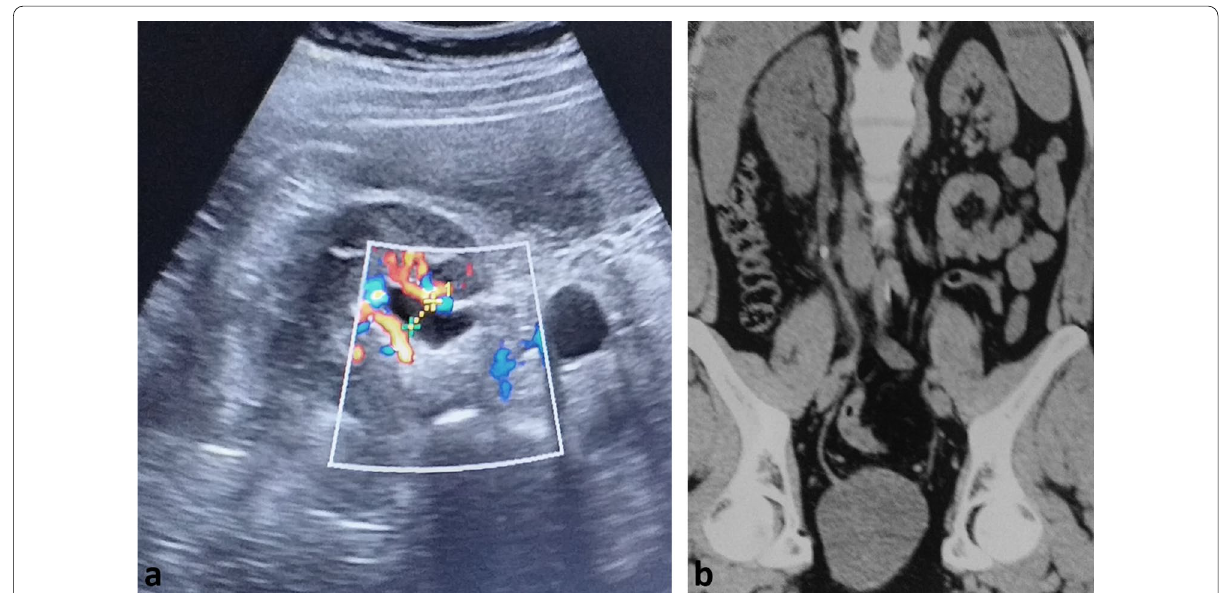
Fig. 13 Ultrasound in the setting of acute ureteric colic showing mild dilatation of the renal pelvis ( a ); b non-contrast CT shows stone at the mid ureter